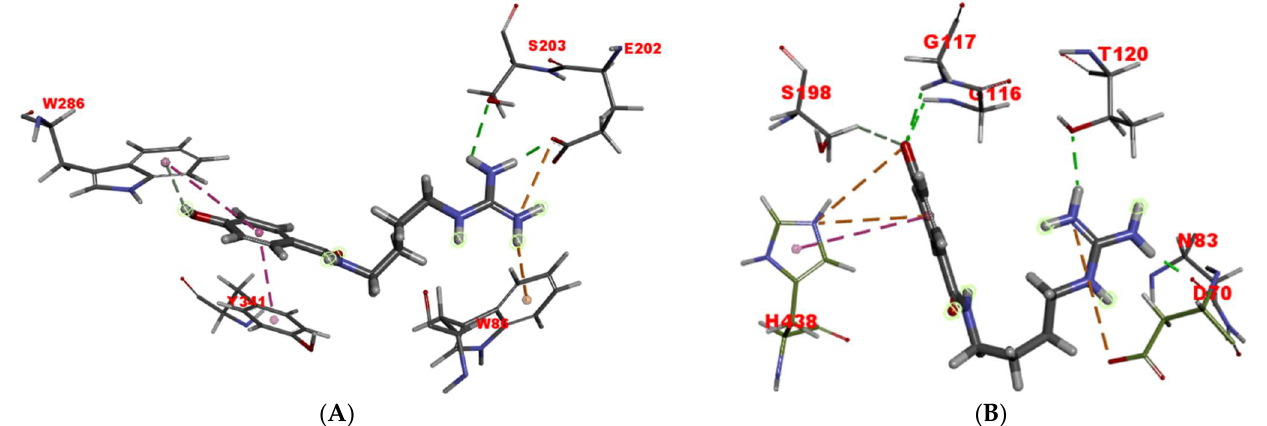
Figure 7. Docking models of compound 1 with AChE ( A ) and BChE ( B